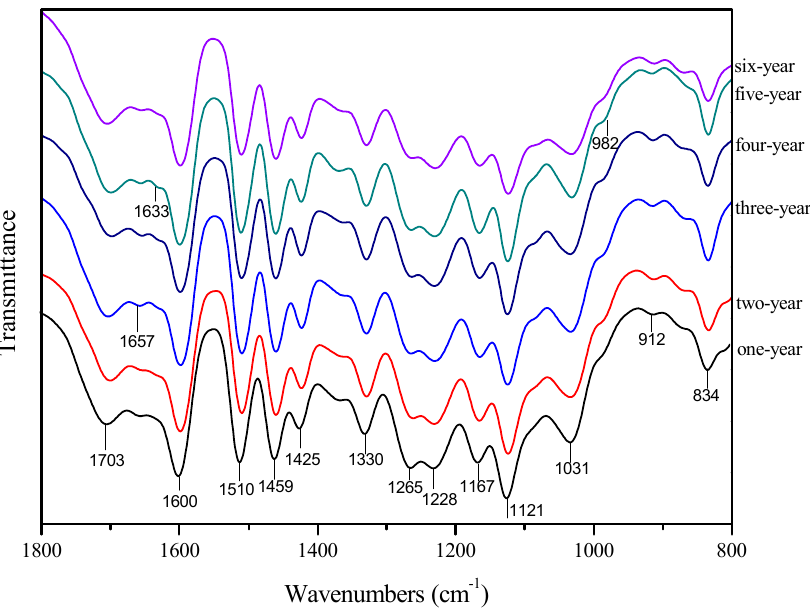
Figure 2. FT-IR spectra of 1–6 years old bamboo lignin.